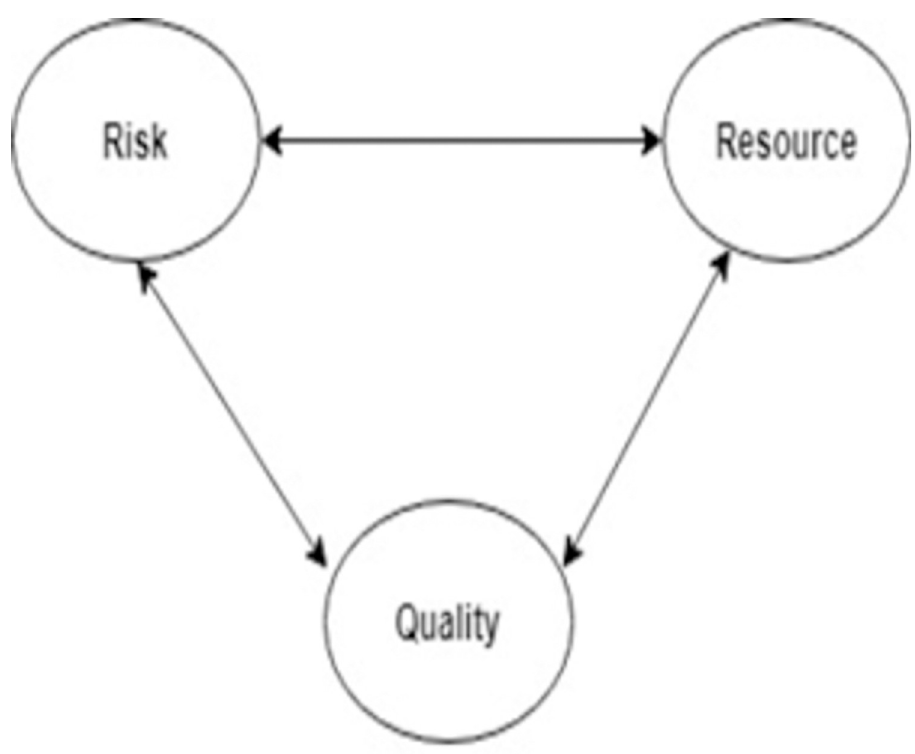
Fig 4. Second triangle of PMBOK six-pointed star framework [25].